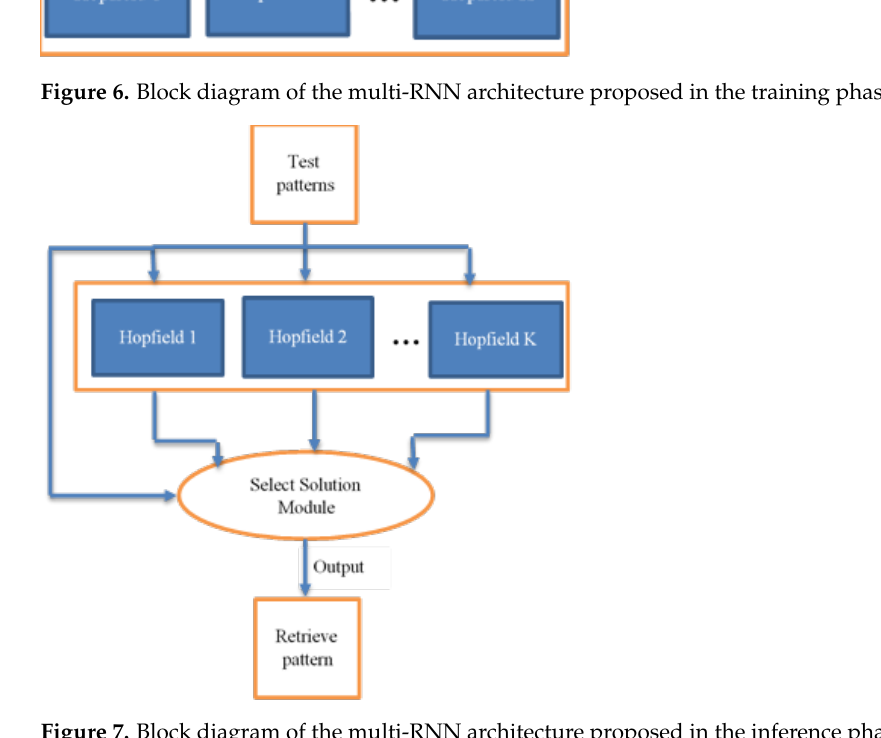
Figure 7. Block diagram of the multi-RNN architecture proposed in the inference phase